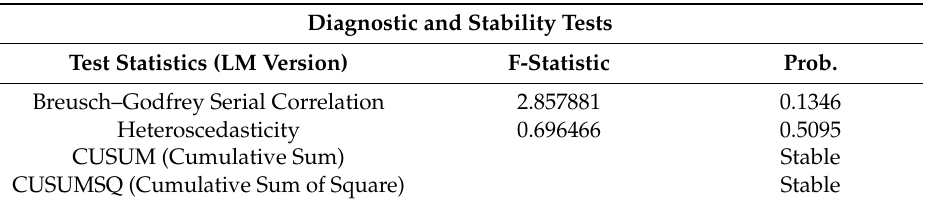
Table 7. Diagnostic and Stability Tests.